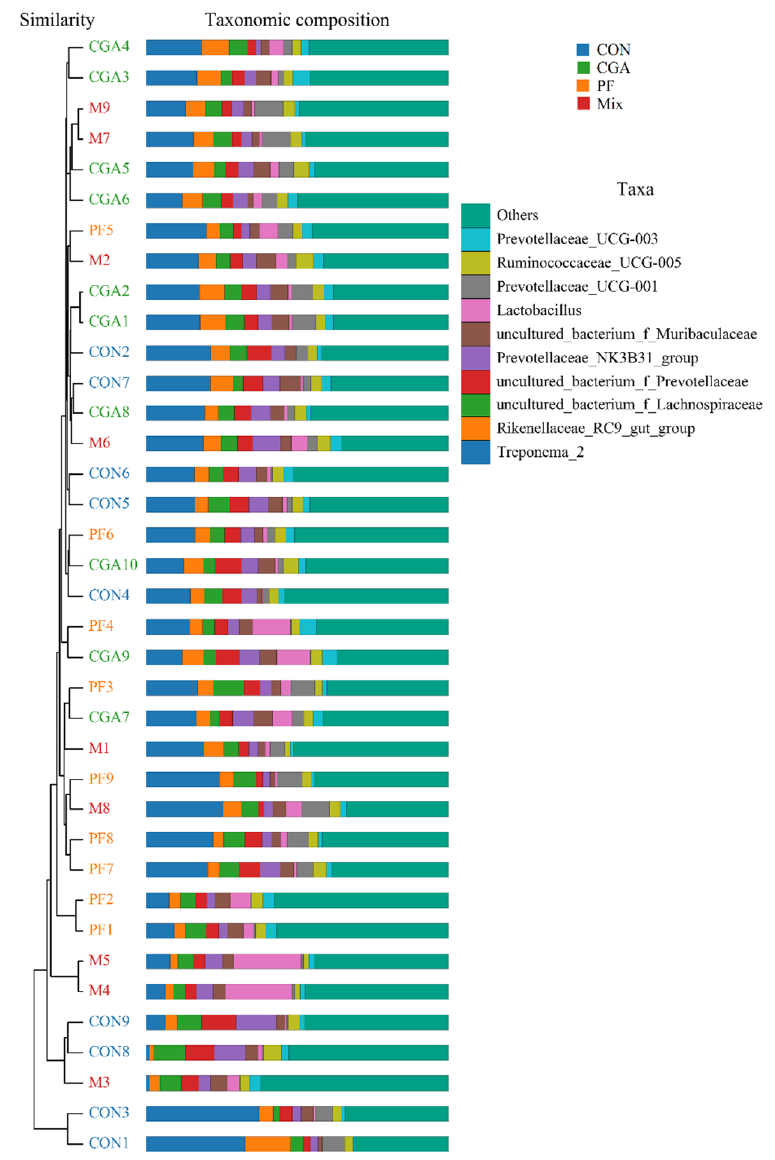
Figure 5. UPGMA clustering analysis of rectal microbe sin finishing pigs. The figure on the right represents the top 10 species according to the species abundance; the others are classified as Others, and those not annotated are classified as Unclassified.